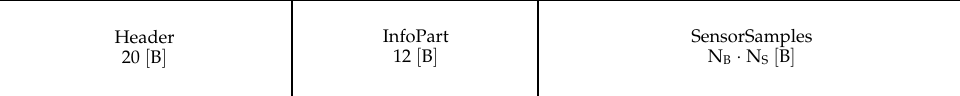
Figure 5. SKM datagram as described by Kongsberg (410224 Revision H). Sizes of data elements not to